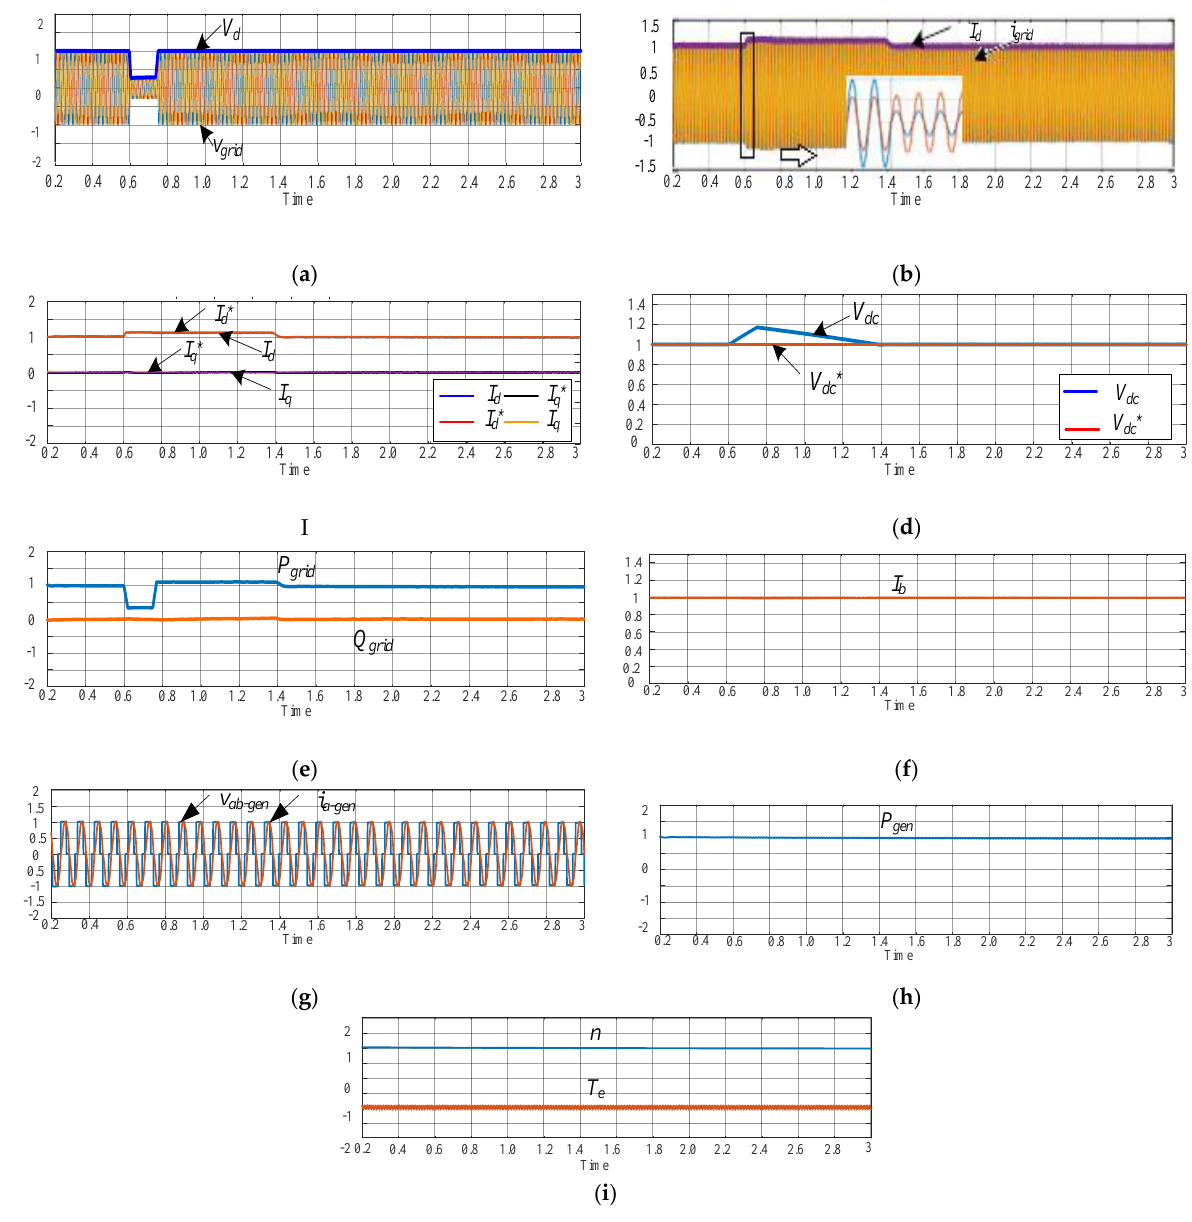
Figure 7. Simulation results during 70% symmetrical grid voltage without the proposed control scheme: ( a ) abc grid voltages 𝑣 𝑔𝑟𝑖𝑑 and d– axis grid voltage 𝑉 𝑑 (p.u.); ( b ) abc grid currents 𝑖 𝑔𝑟𝑖𝑑 and d– axis grid current 𝐼 𝑑 (p.u.); ( c ) d– axis currents 𝐼 𝑑 and reference 𝐼 𝑑∗ with q– axis currents 𝐼 𝑞 and reference 𝐼 𝑞∗ ; ( d ) DC– link voltage 𝑉 𝑑𝑐 and reference 𝑉 𝑑𝑐∗ (p.u); ( e ) grid active power 𝑃 𝑔𝑟𝑖𝑑 and reactive power Q grid (p.u); ( f ) boost chopper current I b and reference I ∗ (p.u); ( g ) PMSG Line- line voltage v ab − gen and phase a– current i a − gen ; ( h ) PMSG active power P gen (p.u); ( i ) PMSG speed n and torque T e